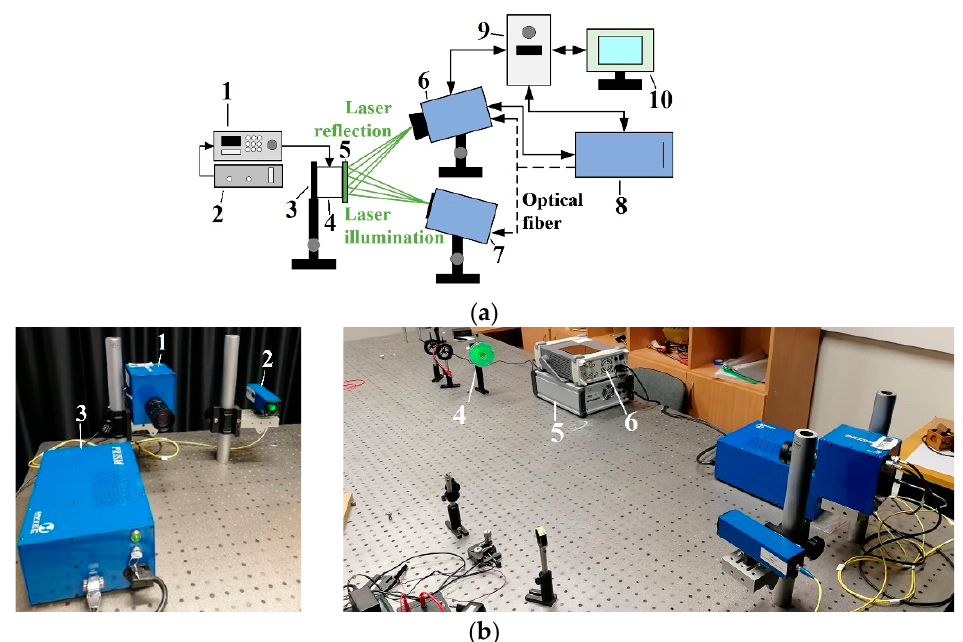
Figure 3. Non-contact holographic measurement system, known as PRISM system. ( a ) Schematic diagram of the PRISM system experimental setup: 1: frequency generator, 2: voltage amplifier, 3: isolated surface for fixing object, 4: piezoelectric actuator, 5: membrane attached to the piezoelectric actuator, 6: camera, 7: illumination head with a green laser, 8: control block, 9: computer, 10: computer screen (image illusion); ( b ) Experimental setup: 1: camera, 2: illumination head with a green laser, 3: control block, 4: membrane attached to a piezoelectric actuator, 5: voltage amplifier, 6: frequency generator.